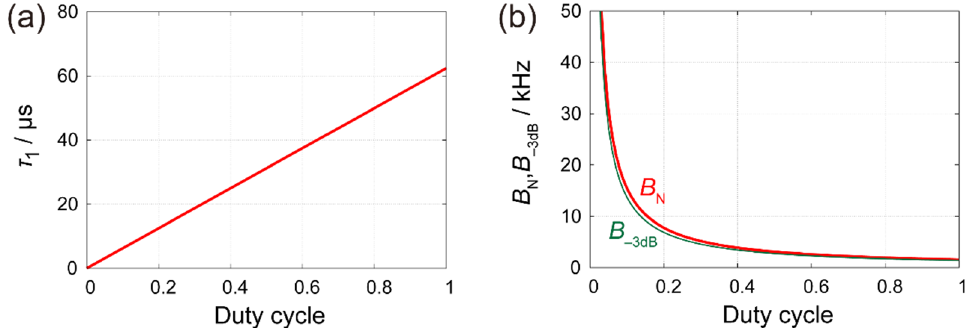
Figure 5. Time constant and bandwidth of the LPF stage at the lock-in amplifier to obtain the highest signal level in BA-PFT-SNDM. ( a ) Time constant of the LPF per one-order ( b ) − 3 dB cut-off (green curve) and equivalent noise bandwidth (red curve).